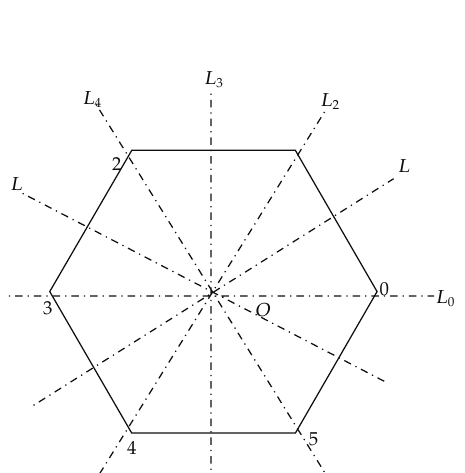
Figure 1: Regular 𝑛 quadrate.